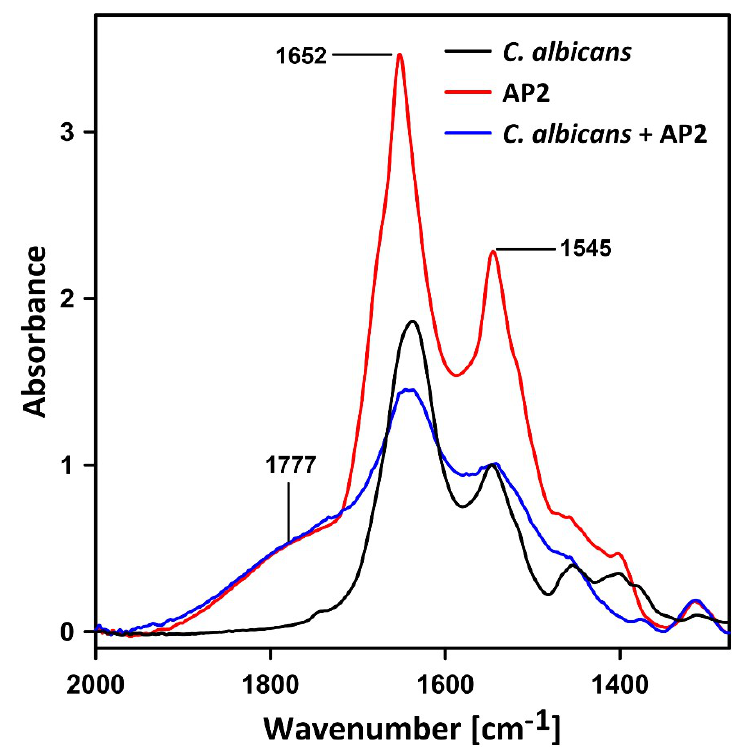
Figure 7. FTIR spectra of C. albicans cells treated with G. mellonella AP2. Infrared absorption spectra in the amide I and amide II region of anionic peptide 2 (AP2) , C. albicans , and AP2-exposed C. albicans cells (marked). The spectra of C. albicans recorded before and after the incubation with AP2 were normalized at the maximum of the amide II band (1545 cm −1 ). The spectrum of pure AP2 was scaled to the same intensity as the spectrum of AP2-exposed C. albicans in the spectral region of 1777 cm −1 , in which cells do not absorb IR radiation.